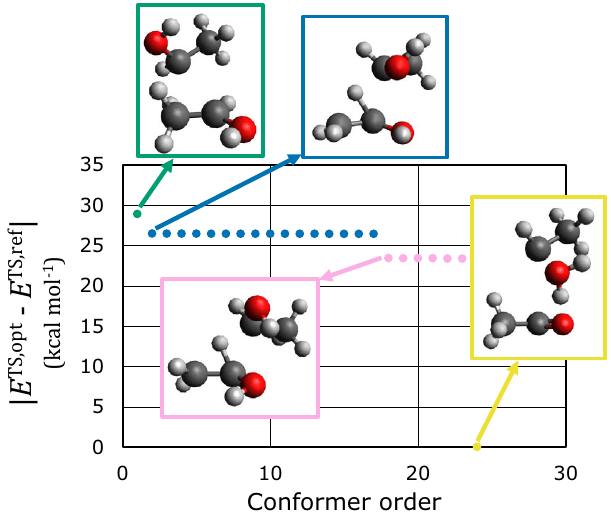
Fig. 5 | Relative energies derived through transition state (TS) exploration. TS exploration was performed for the reaction presented in Fig. 4a using quantum chemical saddle point optimization and the proposed machine learning approach with off-equilibrium samplings of reactants and products. The relative energies of 24TSstructuresfromtheexplorationareplotted,indescendingorderwithrespect to the energy of the reference TS structure ( E TS,opt − E TS,ref ). The energies with the same color share the same conformation. The representative structures are pre- sented in boxes of the same